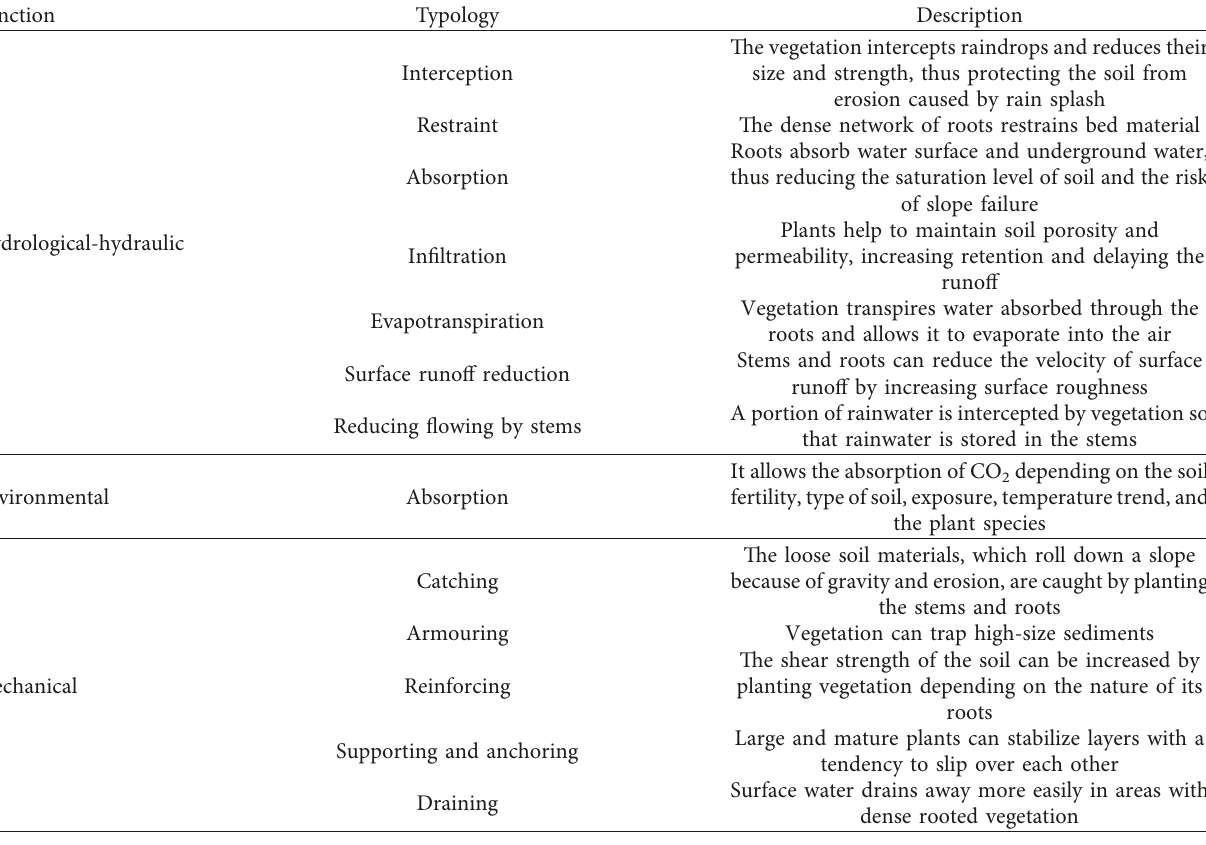
Figure 2: (a) Example of wool geotextiles. (b) Example of woods crib walls. Table 1: Functions of vegetation in environmental engineering measures.